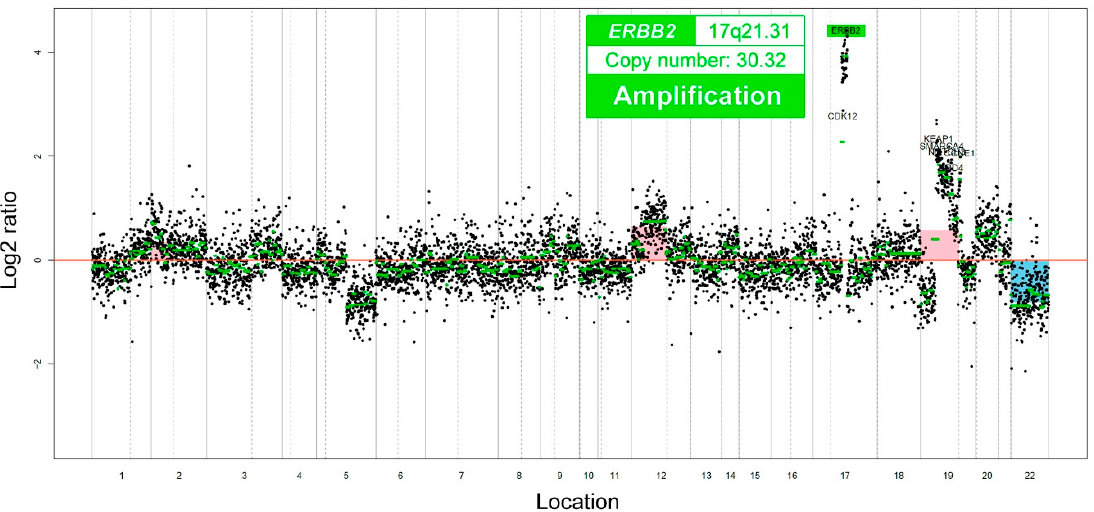
Figure 3. Copy number plots. The Erb-b2 receptor tyrosine kinase 2 ( ERBB2 ) gene is markedly amplified.